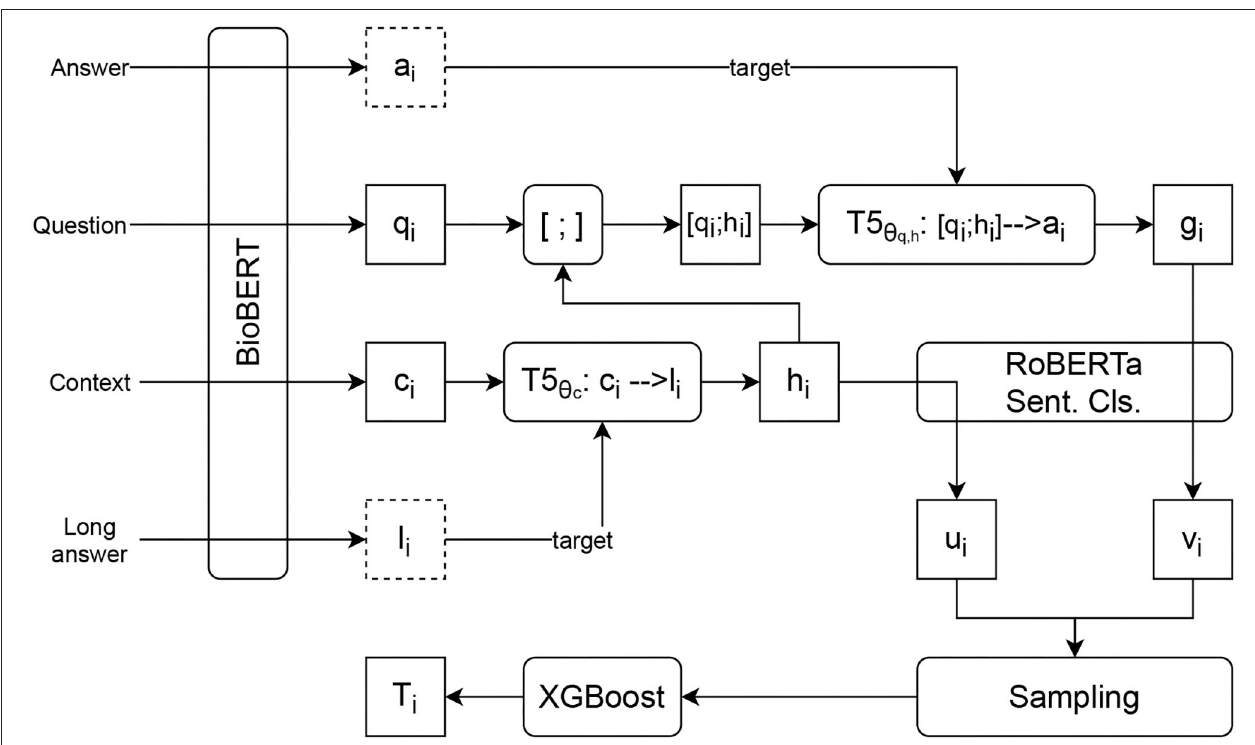
FIGURE 1 | Learning framework of SentiMedQAer: Two T5 models are fine-tuned to produce short forms of the context and the question, which are fed into a RoBERTa model that outputs their sentiment representations. A sampling module is employed to pair these sentiment values utilized to train an XGB classifier, which outputs a confidence score that determines the final prediction